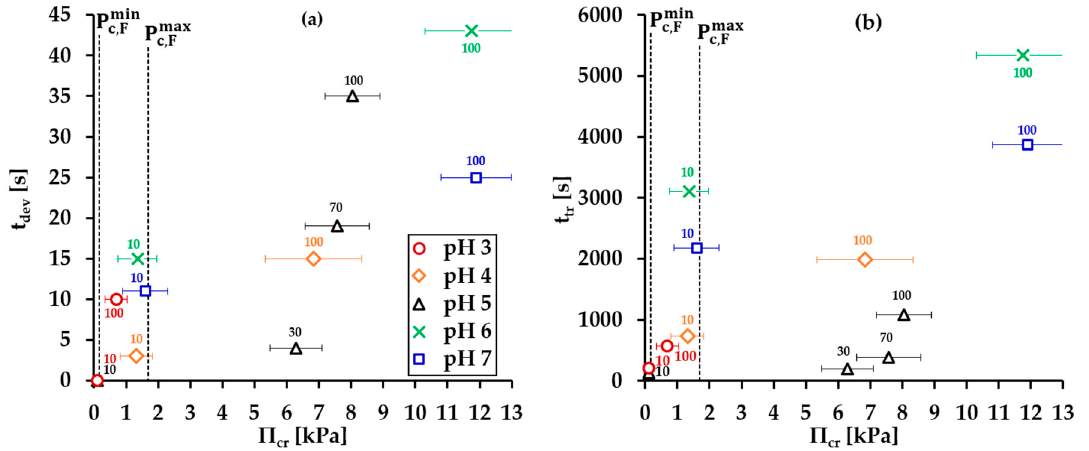
Figure 10. Characteristic times ( a ) t dev and ( b ) t tr of foam decay as a function of the critical pressure of rupture Π cr of single foam films. The vertical dashed lines indicate the range of estimated foam capillary pressures P c,F as explained in the text. Numbers indicate the BLG concentration [ µ